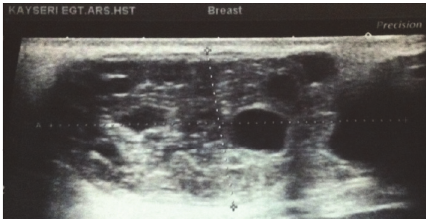
Figure 2: Gray-scale sonogram. Smooth bordered semisolid mass with internally scattered, mostly circumferentially oriented ane- choic multiple cyst, creating rosette appearance and accompanying echogenic material filled the intercystic spaces (hydatid sand).